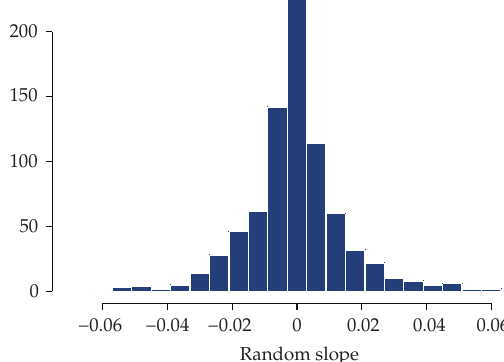
Figure 9: Histogram of random slope estimates.